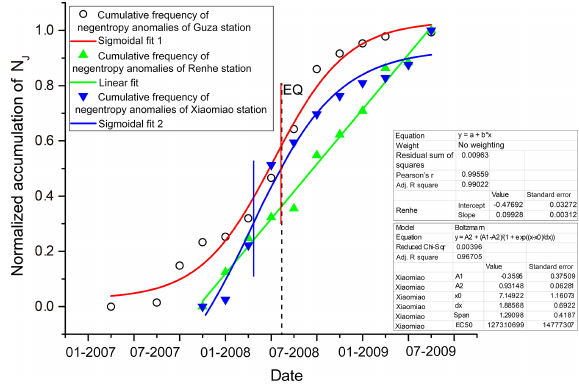
Figure 9. The comparative analysis of cumulative frequency of ne- gentropy anomalies between earthquake period and random time periods. The zero point of green dots is 20 March 2011, and the zero point of blue dots is 24 March 2014.